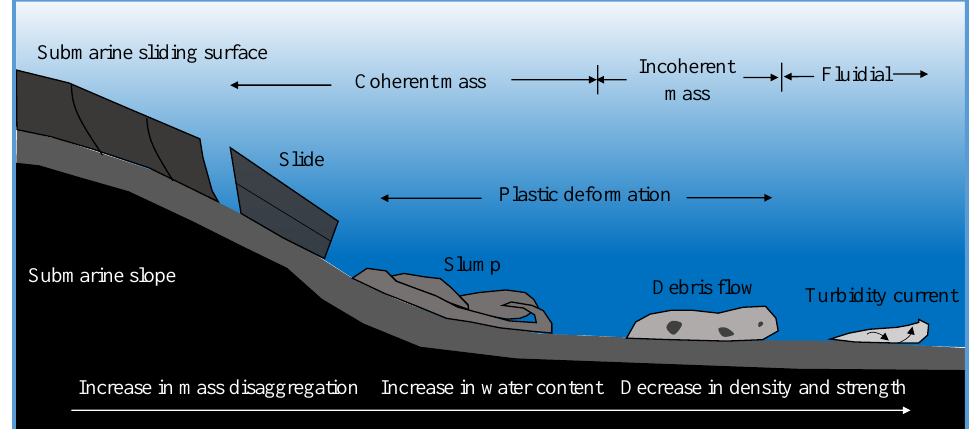
Figure 3. Overview of the stages in the evolution of a submarine landslide. Modified from [13,22].